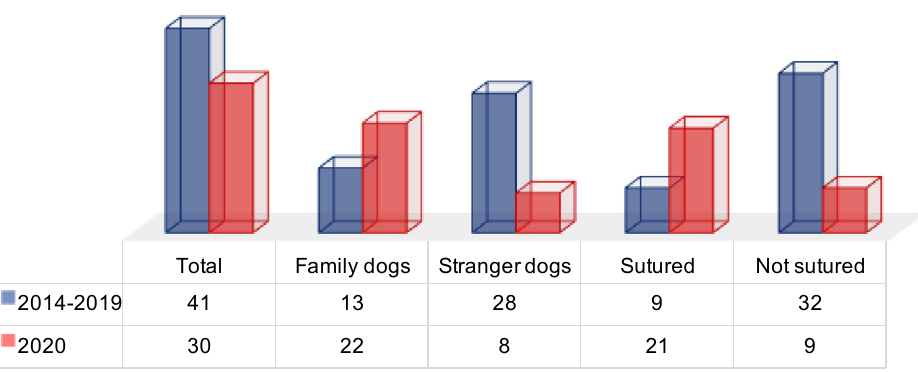
Figure 2. Number of dog bites and sutured injuries (the numbers of 2014-2019 are average values).